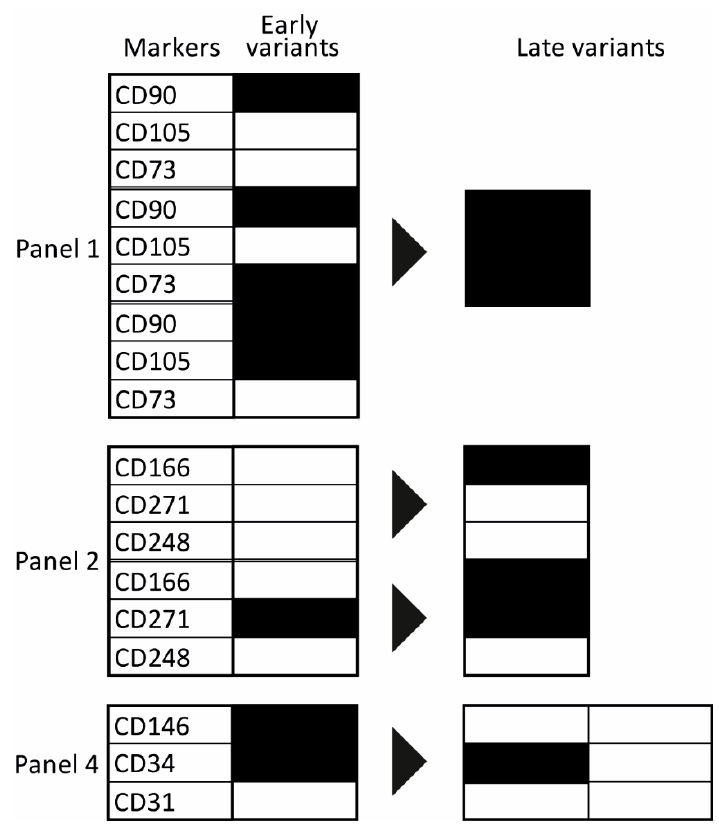
Figure 5. Evolution of predominant phenotypical variants. Panels: 1, mesenchymal stem cell (MSC) markers; 2, wound healing markers; 4, Adipose-derived stromal/stem cell (ASC) markers. A black field indicates that the marker was expressed, a white field indicates that the marker was not expressed. The black arrow reflects the evolution trend from the early stage to later culturing.